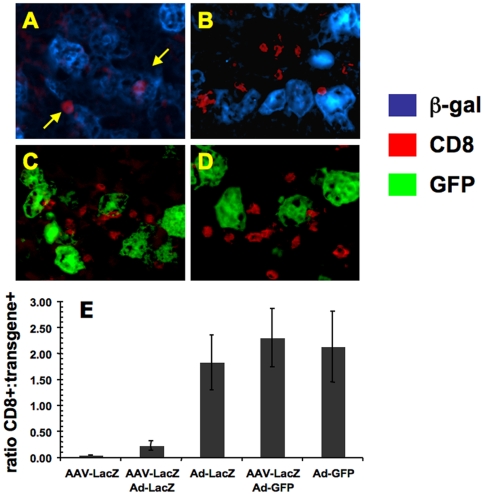
CD8+ cellular infiltrates in adenoviral transduced livers.Liver sections from naïve or AAV-LacZ pre-treated C57BL/6 mice 10 days after Ad-LacZ or Ad-GFP gene transfer. CD8+ cells were stained red with AlexaFluor® 568 while β-gal+ cells were stained green with AlexaFluor® 488. GFP+ cells were green by native fluorescence. A blue-pseudo color after image capture was used to show β-gal+ cells from A. AAV-LacZ/Ad-LacZ and B. Ad-LacZ livers, and the native green fluorescence was used to show GFP+ cells from C. AAV-LacZ/Ad-GFP and D. Ad-GFP livers. E. The ratio of CD8+ staining surrounding either β-gal or GFP producing hepatocytes was determined by capturing the images at 200X and analyzing with Image Pro software. Data are average±SD for n = 4 mice/experimental group. Arrows in A. point toward CD8+ cells.